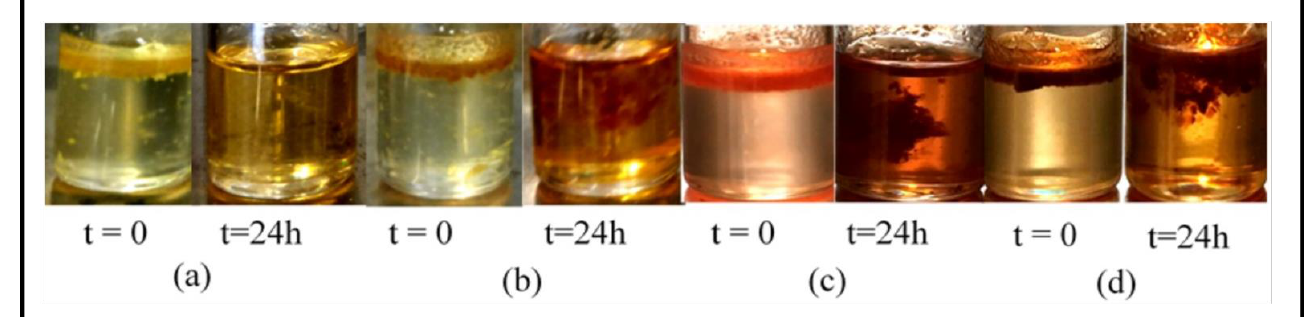
Figure 6. Solubility of TG1 ( a ), TG1A150 ( b ), IMG1 ( c ) and IMG1A150 ( d ) in dichlorobenzene at 120 °C for 24 h. Table 4. Melt Volume Rate of PPgMA and its cross-linked